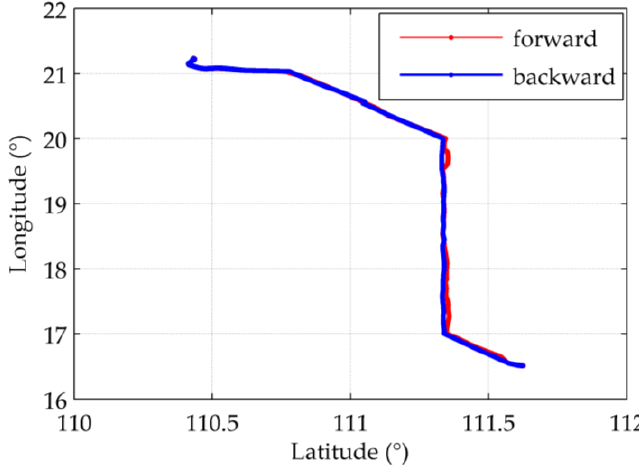
Figure 9. The route of a round-trip experiment during the sea test.